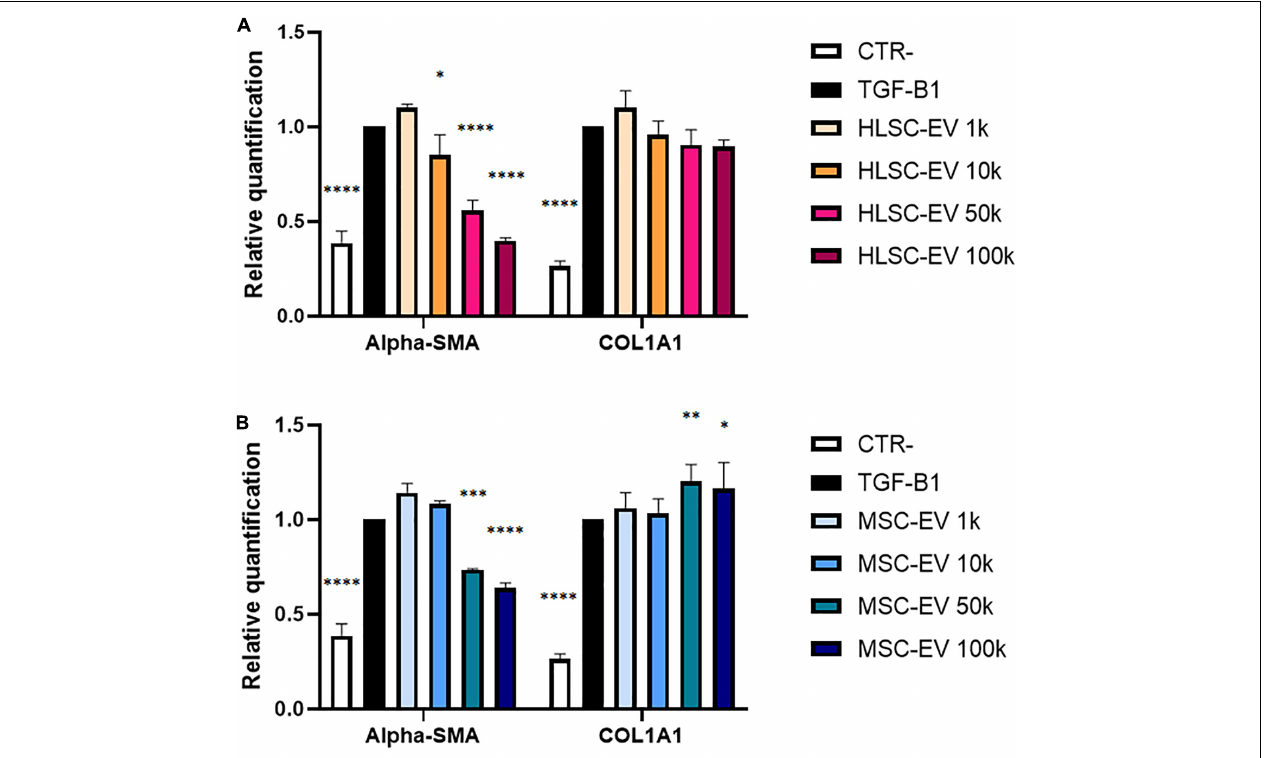
FIGURE 2 | Evaluation of dose-response EV effect on activated LX-2. (A,B) QRT-PCR analysis of the expression of α -SMA and COL1A1 in activated LX-2 after a 24-h incubation with HLSC-EVs (A) and MSC-EVs (B) . Gene expression levels were normalized on those of the housekeeping gene TBP. LX-2 cells activated with TGF- β 1 (10 ng/mL) not incubated with EVs were used as reference control. LX-2 cultured without TGF- β 1 were used as negative control (CTR-). Statistical analysis was performed on results obtained from three independent experiments, using the Two-way ANOVA test: ∗ p < 0.05; ∗∗ p < 0.01; ∗∗∗ p < 0.001; ∗∗∗∗ p <